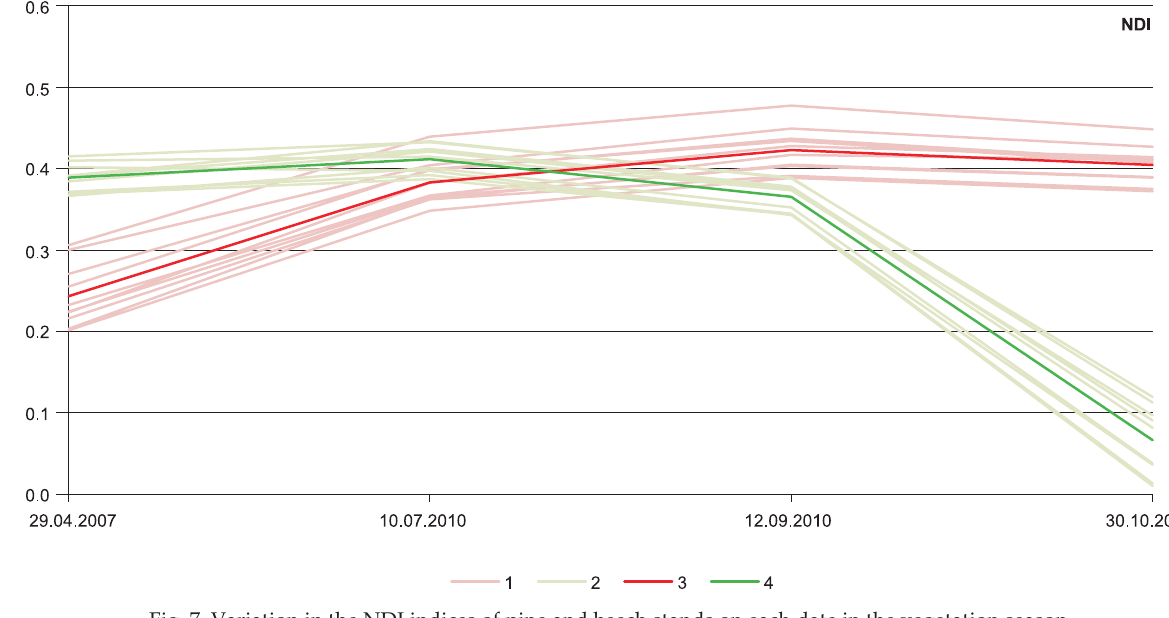
Fig. 7. Variation in the NDI indices of pine and beech stands on each date in the vegetation season 1 – variation in indices for test areas of pine; 2 – variation in indices for test areas of beech; 3 – average index for pine stand; 4 – average index for beech